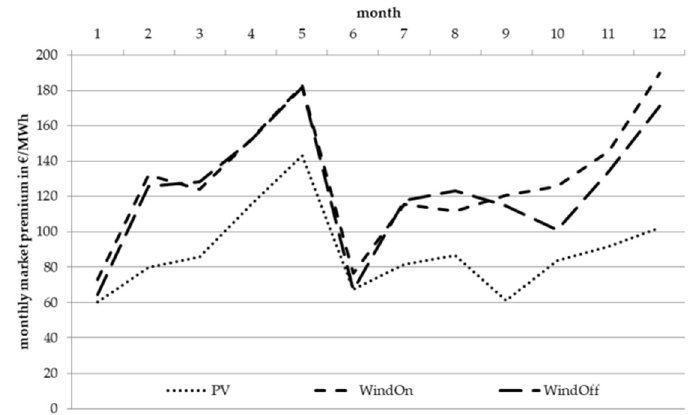
Figure A4. Development of the market premium for PV, wind onshore and wind offshore in the extended wind scenario.